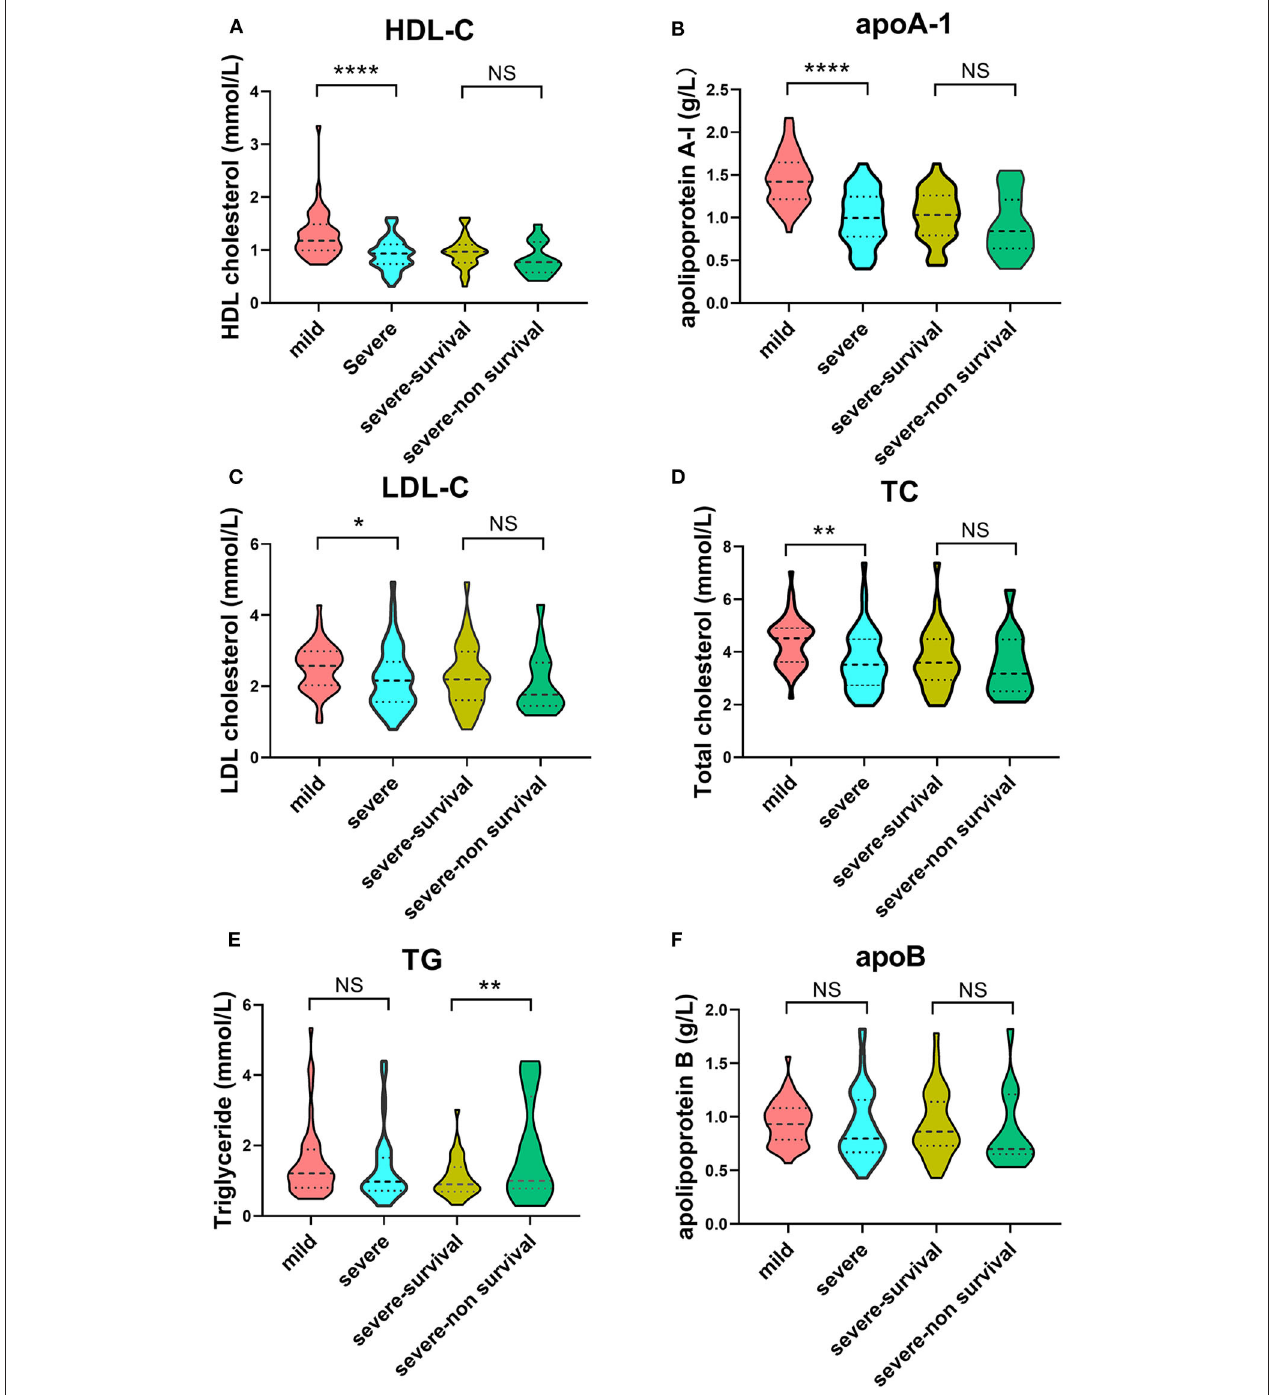
FIGURE 2 | Violin plots of lipid features of mild vs. severe and severe survivors vs. severe non-survivors. Plots demonstrate lipid concentration within each group. Horizontal dotted lines represent first and third quartiles; horizontal dashed lines within plot indicate median of lipid levels. Dunnett’s test was applied to assess significance of differences with mild cases serving as the control. (**** p < 0.0001, ** p < 0.01, * p < 0.05).